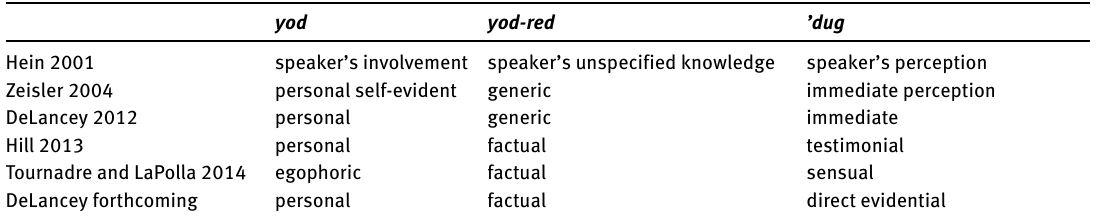
Table 3: Labels proposed for the threefold distinction of existential copulas in Central Tibetan (and related varieties such as Tabo Spiti, see Hein